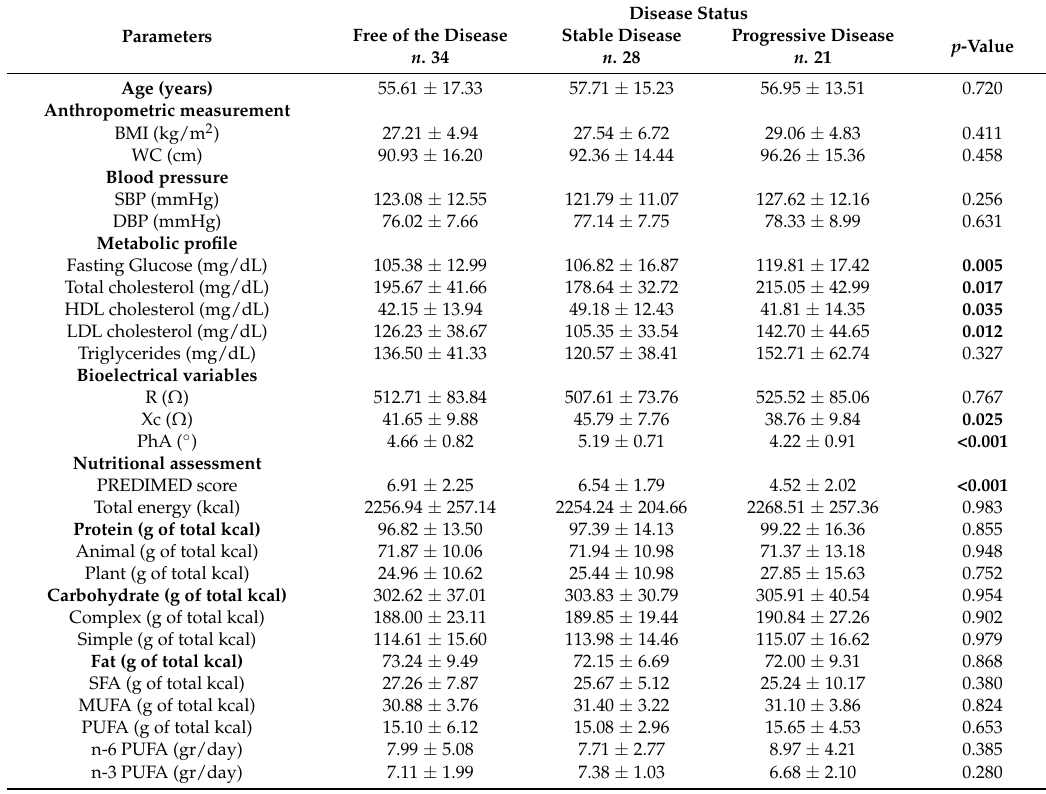
Table 4. Demographic, clinical, metabolic and bioelectrical parameters in the GEP-NET patients according to disease status.